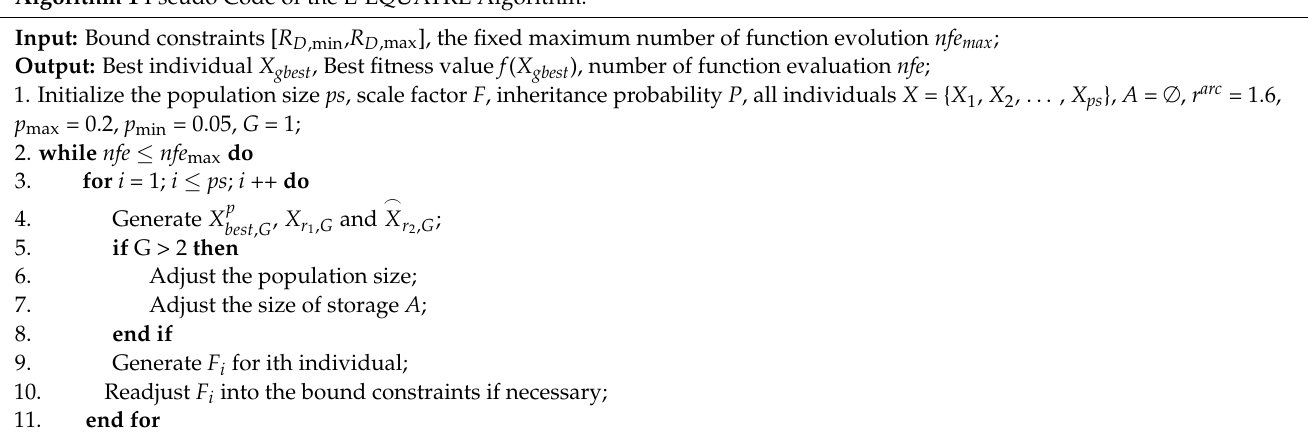
Algorithm 1 Pseudo Code of the L-EQUATRE